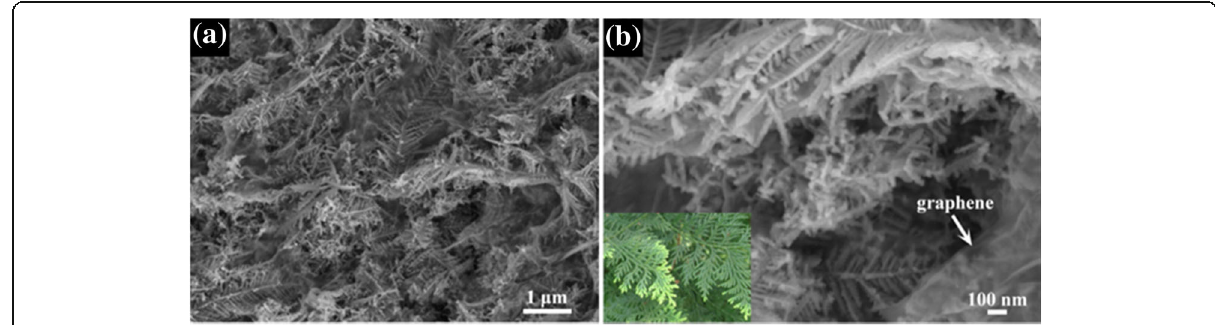
Fig. 3 FESEM images of the Cu(OH) 2 /graphene composite at a low and b high magnification